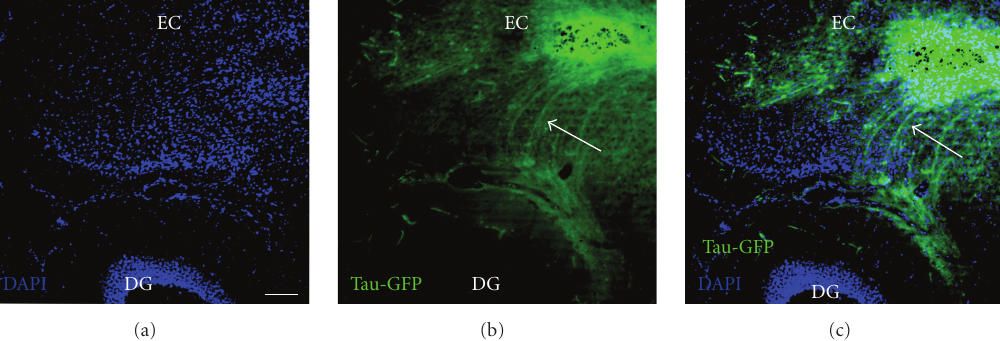
Figure 2: A neurosphere transplant after 3 weeks survival. The transplant is located in the entorhinal cortex (EC), and a strong fiber bundle directed towards the dentate gyrus has developed. GFP positive labeled fibers mostly stop in the area of the hippocampal fissure. (a) DAPI staining. Scale bar = 100 μ m. (b) GFP labeled neurosphere transplant with fiber bundle. (c) Combined image.